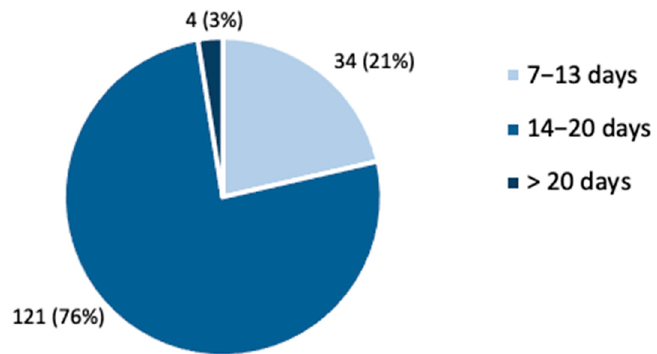
Figure 2. Study population ( n , %) according to the duration of PD-MCT.